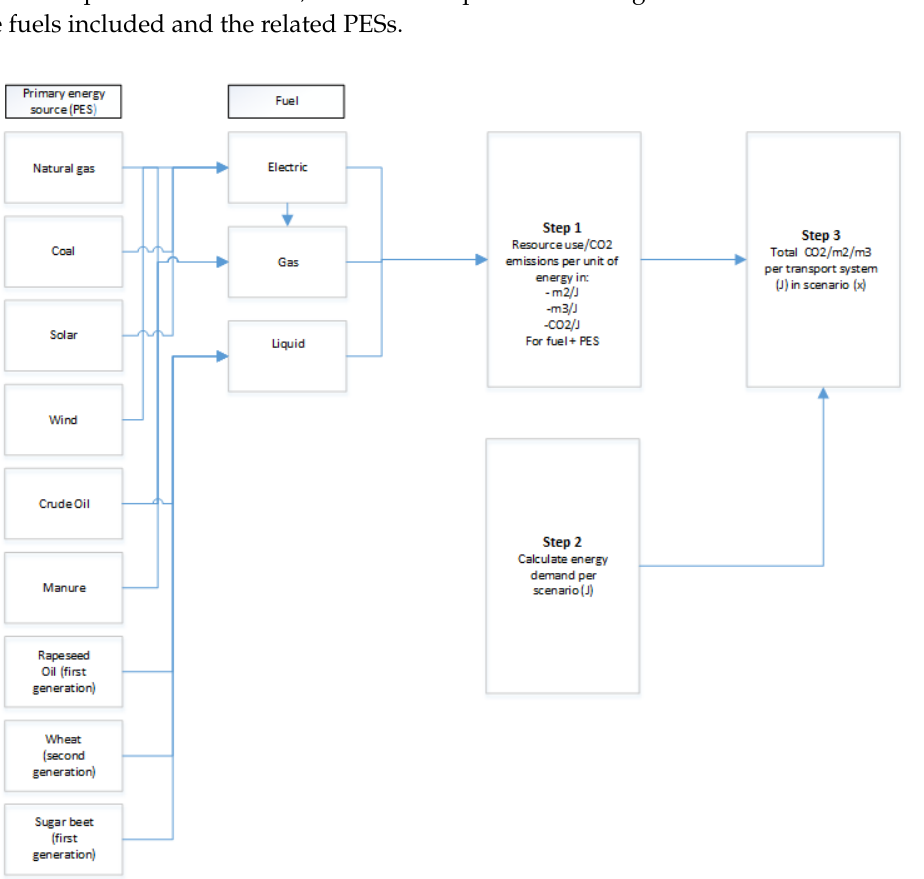
Figure 1. Three calculation steps, the fuels applied and the related PESs for the assessment of carbon, land and water footprints related to different fuel options for transport in the Netherlands using base year 2016 (note: wheat includes the wheat crop for first generation bioethanol and wheat straw for second generation